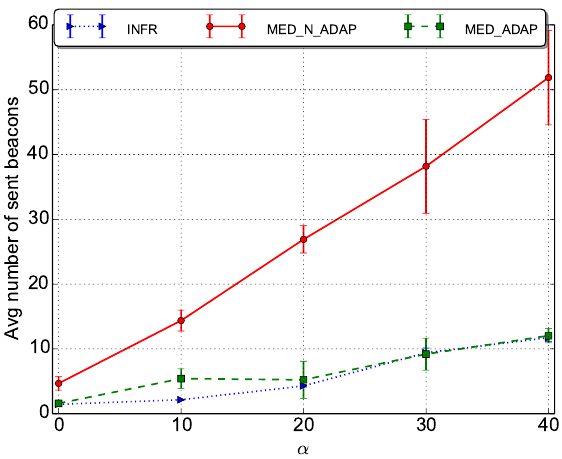
Figure 4. Average number of beacons sent per data packet per node.